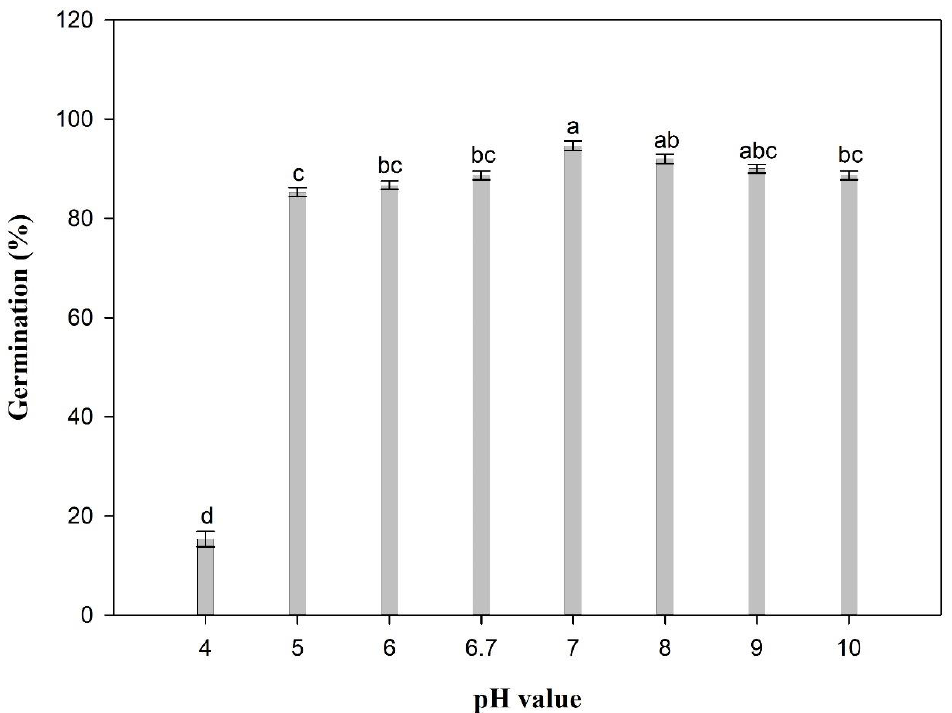
Figure 1. Effect of buffered pH on the germination of Vicia villosa seeds incubated at 20 °C under a 12/12-h dark/light photoperiod for 21 d. The vertical bars represent the standard error of the means. Different letters indicate significant differences according to Tukey’s HSD test at p ≤ 0.05.